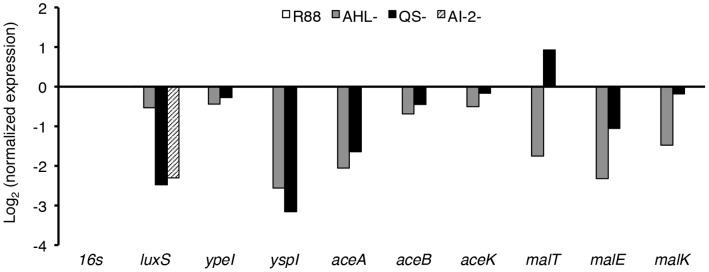
AHL-based QS regulates secondary metabolism.RNA was isolated from the indicated strains of Y. pestis, and levels of mRNA were measured by qRT-PCR as outlined in Material and Methods. Data represents the mean of triplicate measurements of the transcript differences between each mutant and that of strain R88 normalized to the 16 S rRNA of each sample, and are representative of at least three independent experiments. AHL– = strain R114; QS– = strain R115; AI-2– = strain ISM1980.